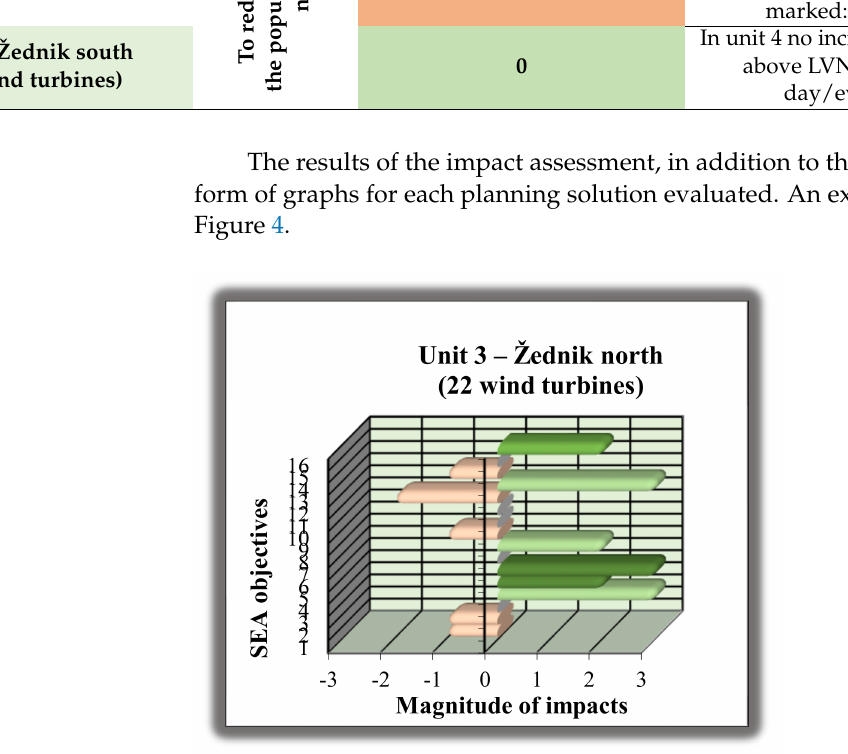
Figure 4. Results of modeling the spatial dispersion of noise for the night